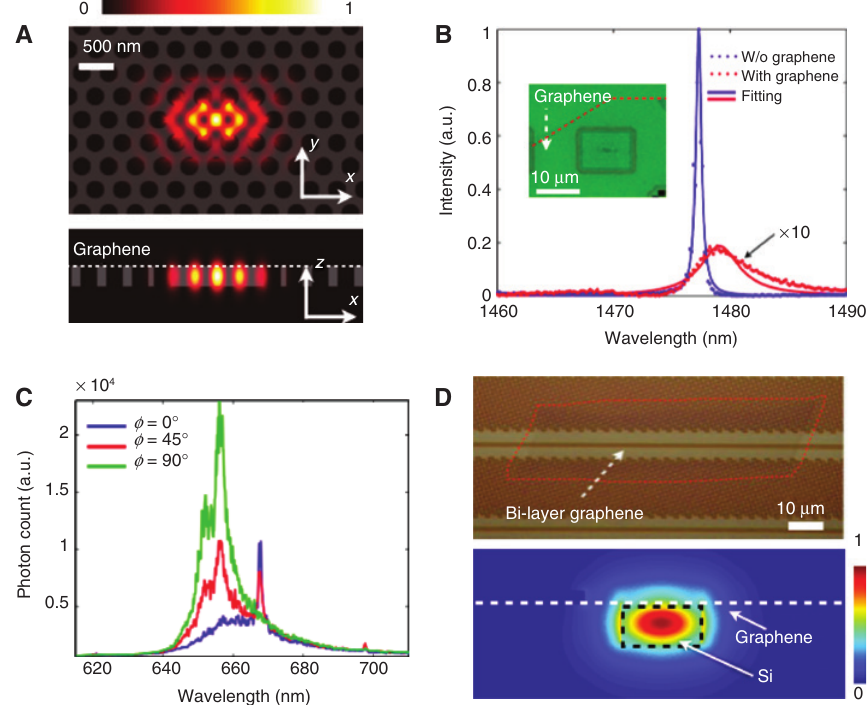
Figure 1: (A) Simulated electric field distribution of a PPC L3 cavity. Bottom panel shows the cross-sectional view of the cavity mode. The graphene layer on the surface of the suspended PPC membrane can couple to the evanescent field of the resonant mode. (B) Reflection spectrum of a GaP PPC cavity before and after coupling to a single layer of graphene. Inset: Optical image of the graphene-PPC cavity device. (C) Fluorescence of single-layer MoS coupled to a PPC cavity [18]. Red, blue, and green curves show the PL collect at a polarization angle 2 of 0 ° , 45 ° , and 90 ° . (D) Top: Optical image of a 70- μ m-long graphene couples to a silicon waveguide. Bottom: Simulated waveguide mode couples to the graphene sheet deposited on the top surface of silicon